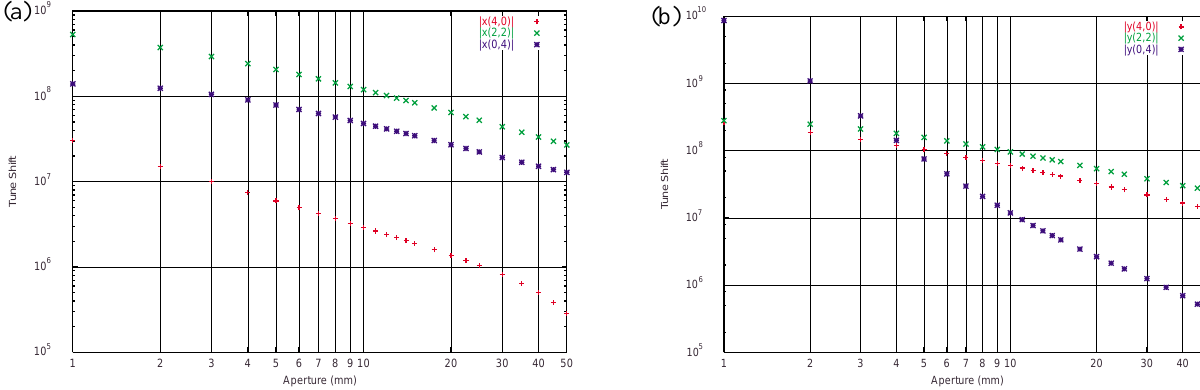
FIG. 10. (Color) Fourth-order amplitude dependent tune shifts as a function of aperture in log-log scale: (a) x tune shifts and (b) y tune shifts. The maximum slope is around